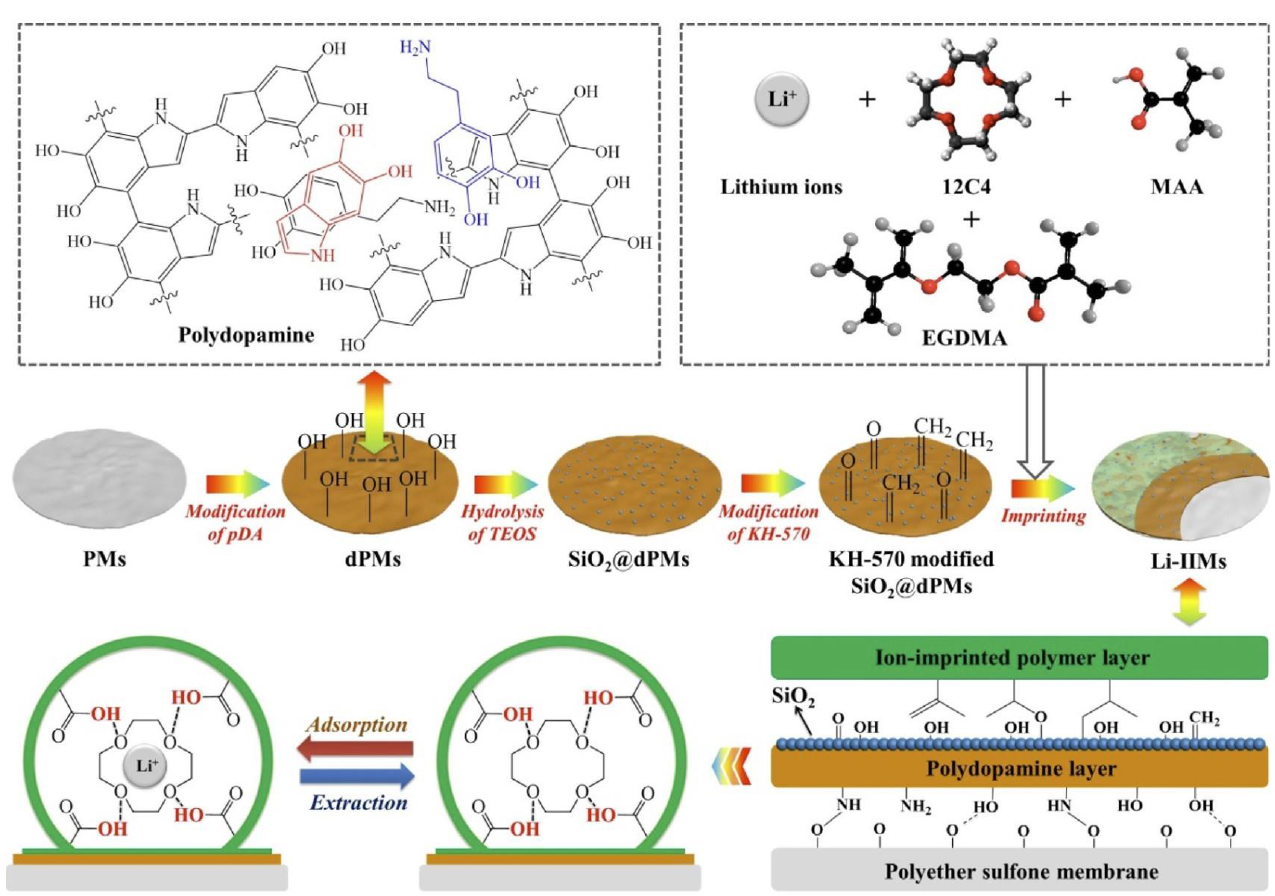
Figure 10. Schematic diagram for the preparation of an ion-imprinted polymer membrane [93]. Reprinted from Applied Surface Science, v. 427, Lu et al., Multilayered ion-imprinted membranes with high selectivity towards Li+ based on the synergistic effect of 12-crown-4 and polyether sulfone, 931 – 941, Copyright 2018, with permission from Elsevier.